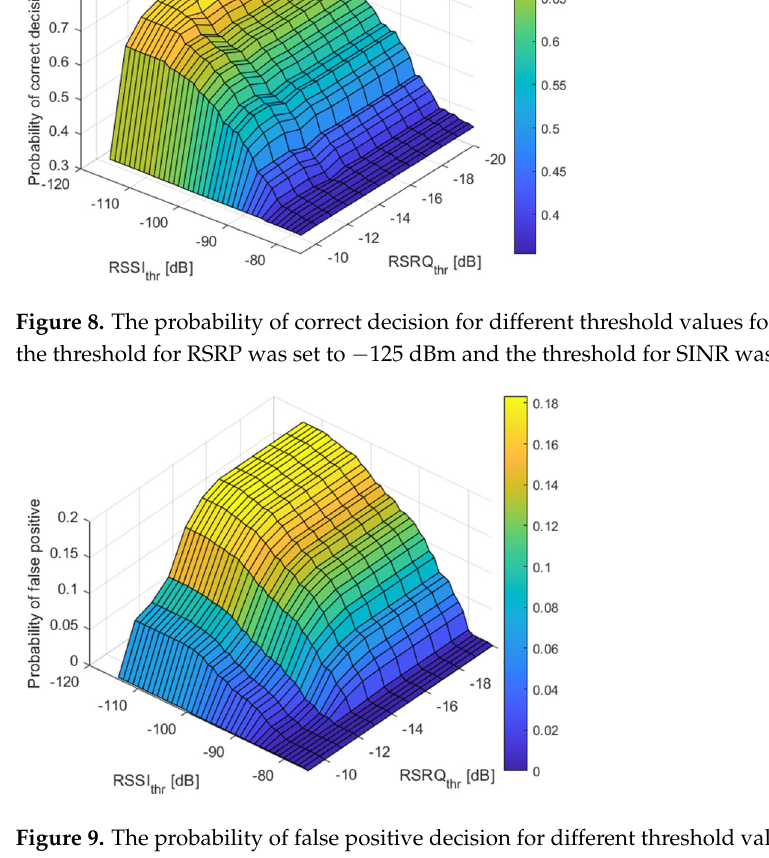
Figure 9. The probability of false positive decision for different threshold values for RSSI and RSRQ while the threshold for RSRP was set to −125 dBm and the threshold for SINR was set to 0 dB.